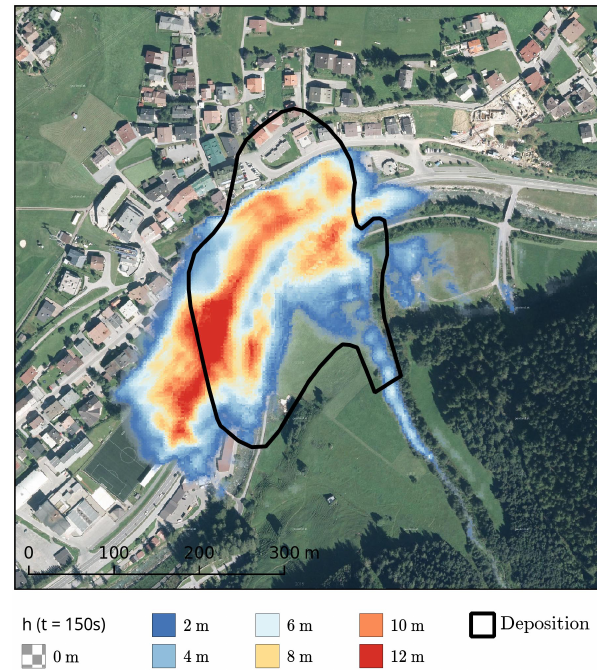
Figure 9. Flow thickness field h at t = 150s of the second-order OpenFOAM simulation ( (cid:49) = 3 . 75m) and the documented depo- sition area. The flow thickness field in the last time step should roughly replicate the deposition. The bulge on the orographic right side of the deposition area is not matched by any simulation. How- ever, some interesting details, such as the tail of the avalanche are represented well in OpenFOAM simulations. Map data: http: //basemap.at (last access: 1 March